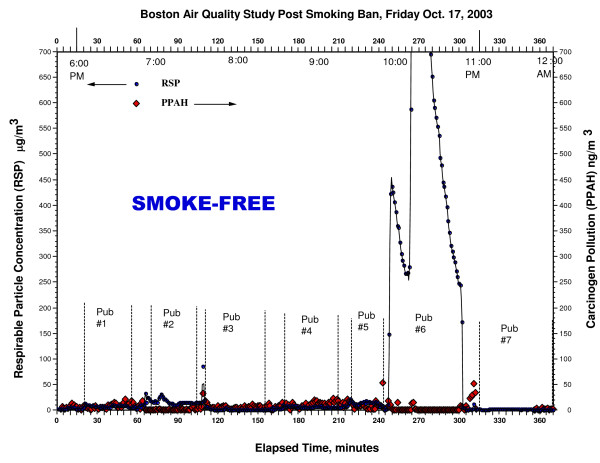
Measurements of RSP and PPAH as a function of time after the Boston smoking ban on Friday, October 17, 2003 from 6 PM to 12 AM in the same 7 hospitality venues shown in Figure 1. Pub #6 had high carbon monoxide levels before and after the ban; this was reported to Boston Public Health, whose investigation later disclosed this was due to fumes from a malfunctioning gas-fired deep fat fryer. Outdoor air pollution levels appear between the dotted lines bracketing the indoor levels in each pub.